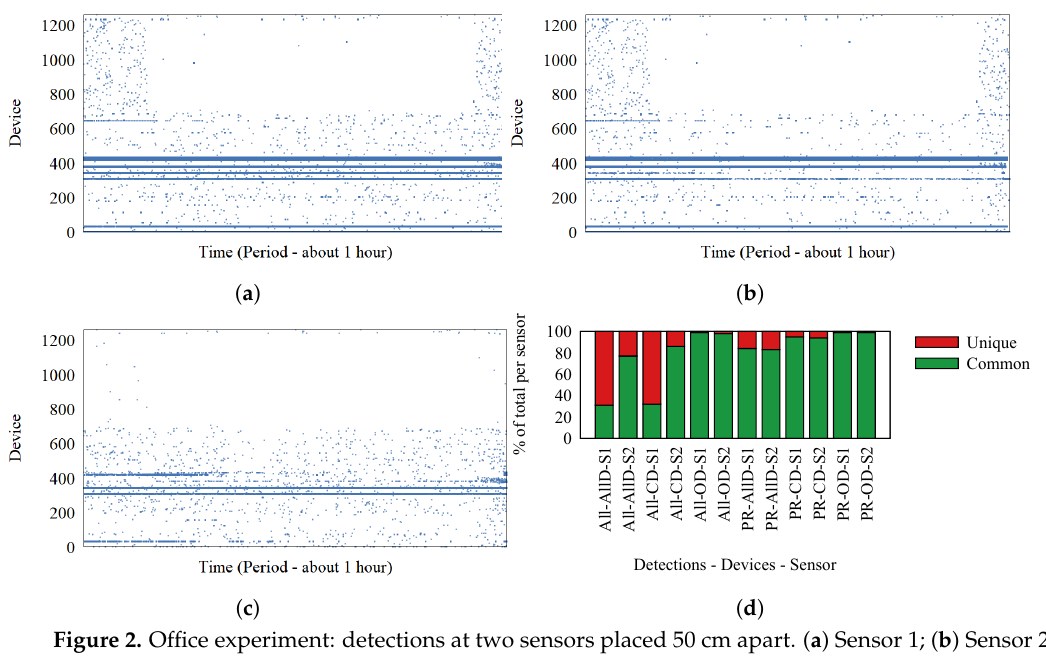
Figure 2. Office experiment: detections at two sensors placed 50 cm apart. ( a ) Sensor 1; ( b ) Sensor 2; ( c ) ( S 1 − S 2 ) ∪ ( S 2 − S 1 ) , S1 and S2 are detections at sensors; ( d ) differences between the sensors. AllD, all devs; CD, common devs; OD, our devs. All, all frame types; PR, only probe